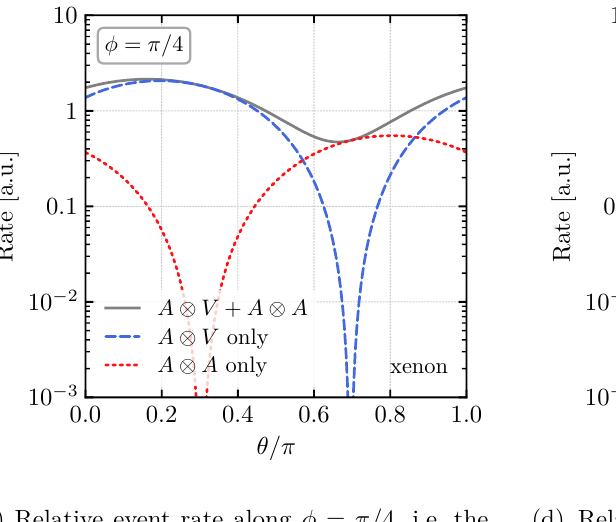
(c) Relative event rate along φ = π/ 4 , i.e. the (d) Relative event rate along φ = 0 . 02 that isospin limit. passes throught the global minimum. Figure 1. The direct detection rate for m χ = 100 GeV using the parameterisation of eq. (2.6) with normalisation corresponding to the overall size of the Wilson coefficients. The blue (orange) star shows the benchmark point BM1 (BM2). The solid grey curve in the upper-right panel, ((b)), and both lower panels, ((c)) & ((d)), show the combined relative rate with the normalisation of panel ((a)) along different lines in the two-dimensional plot, while the dashed (blue) and dotted (red) curves show the sole A ⊗ V and A ⊗ A contributions along the same line, respectively.